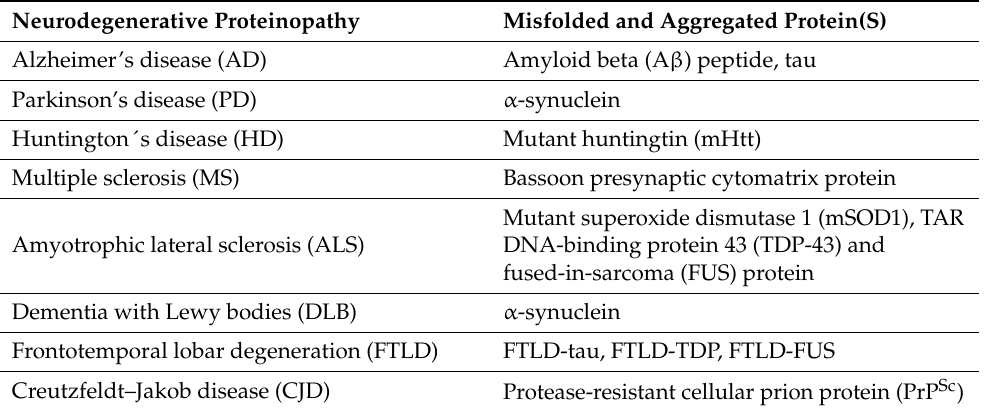
Table 1. Misfolded and aggregated proteins in neurodegenerative